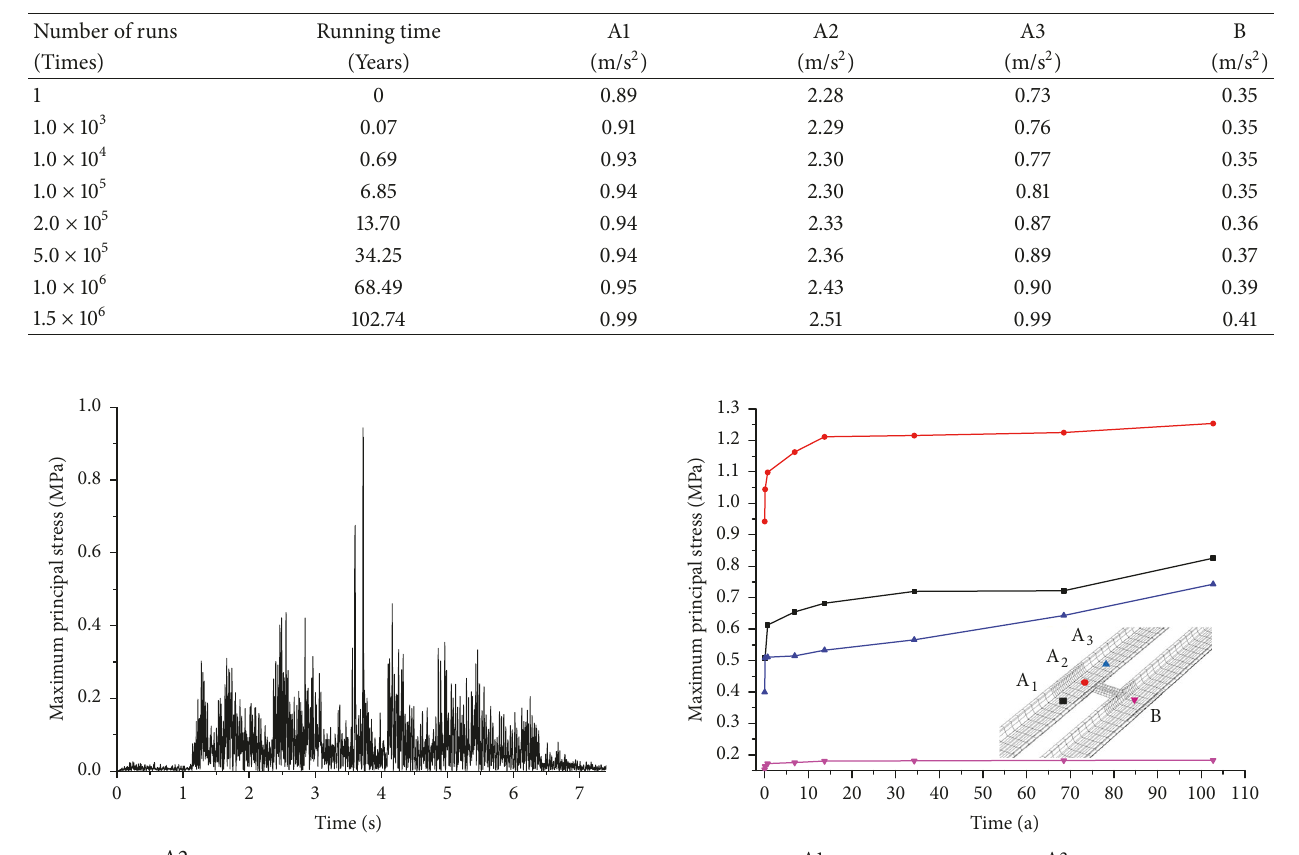
Table 2: Acceleration amplitude of tunnel analysis points.